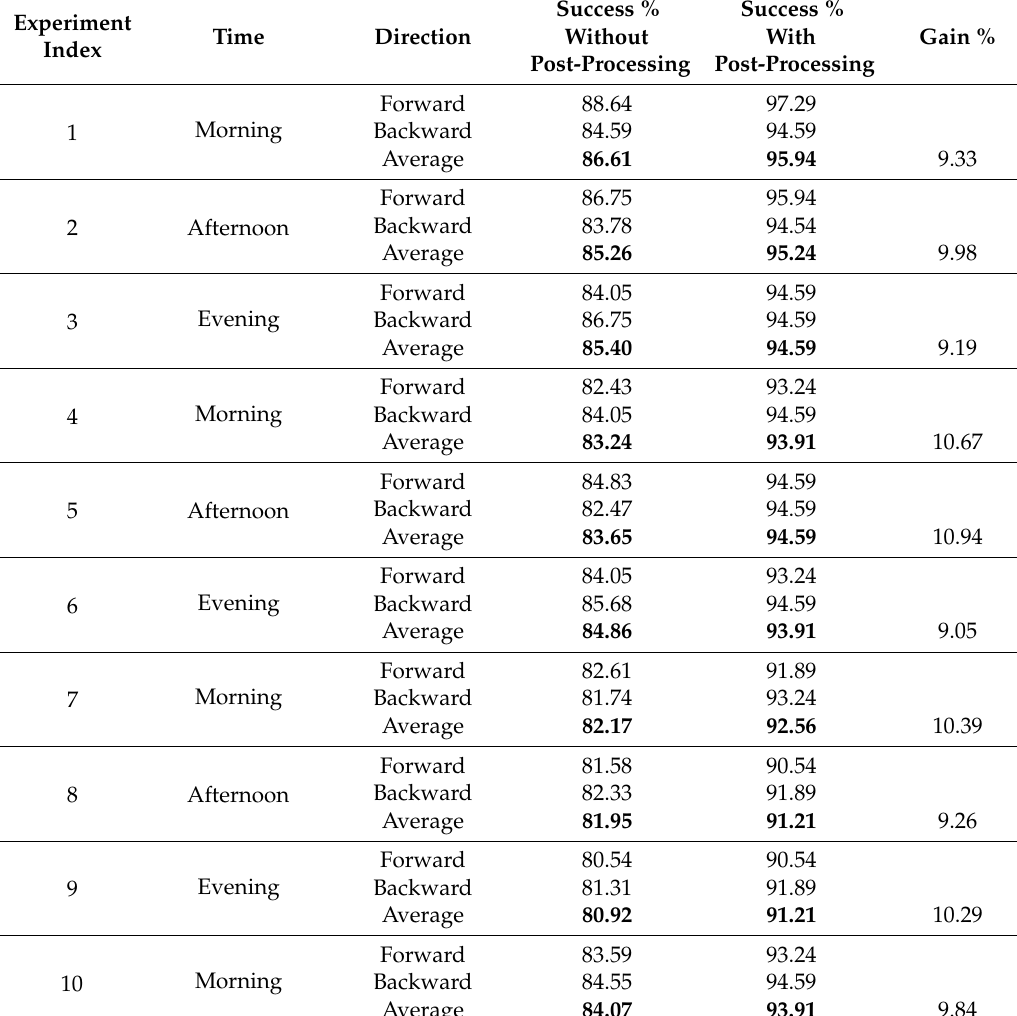
Table 3. Summary of experimental